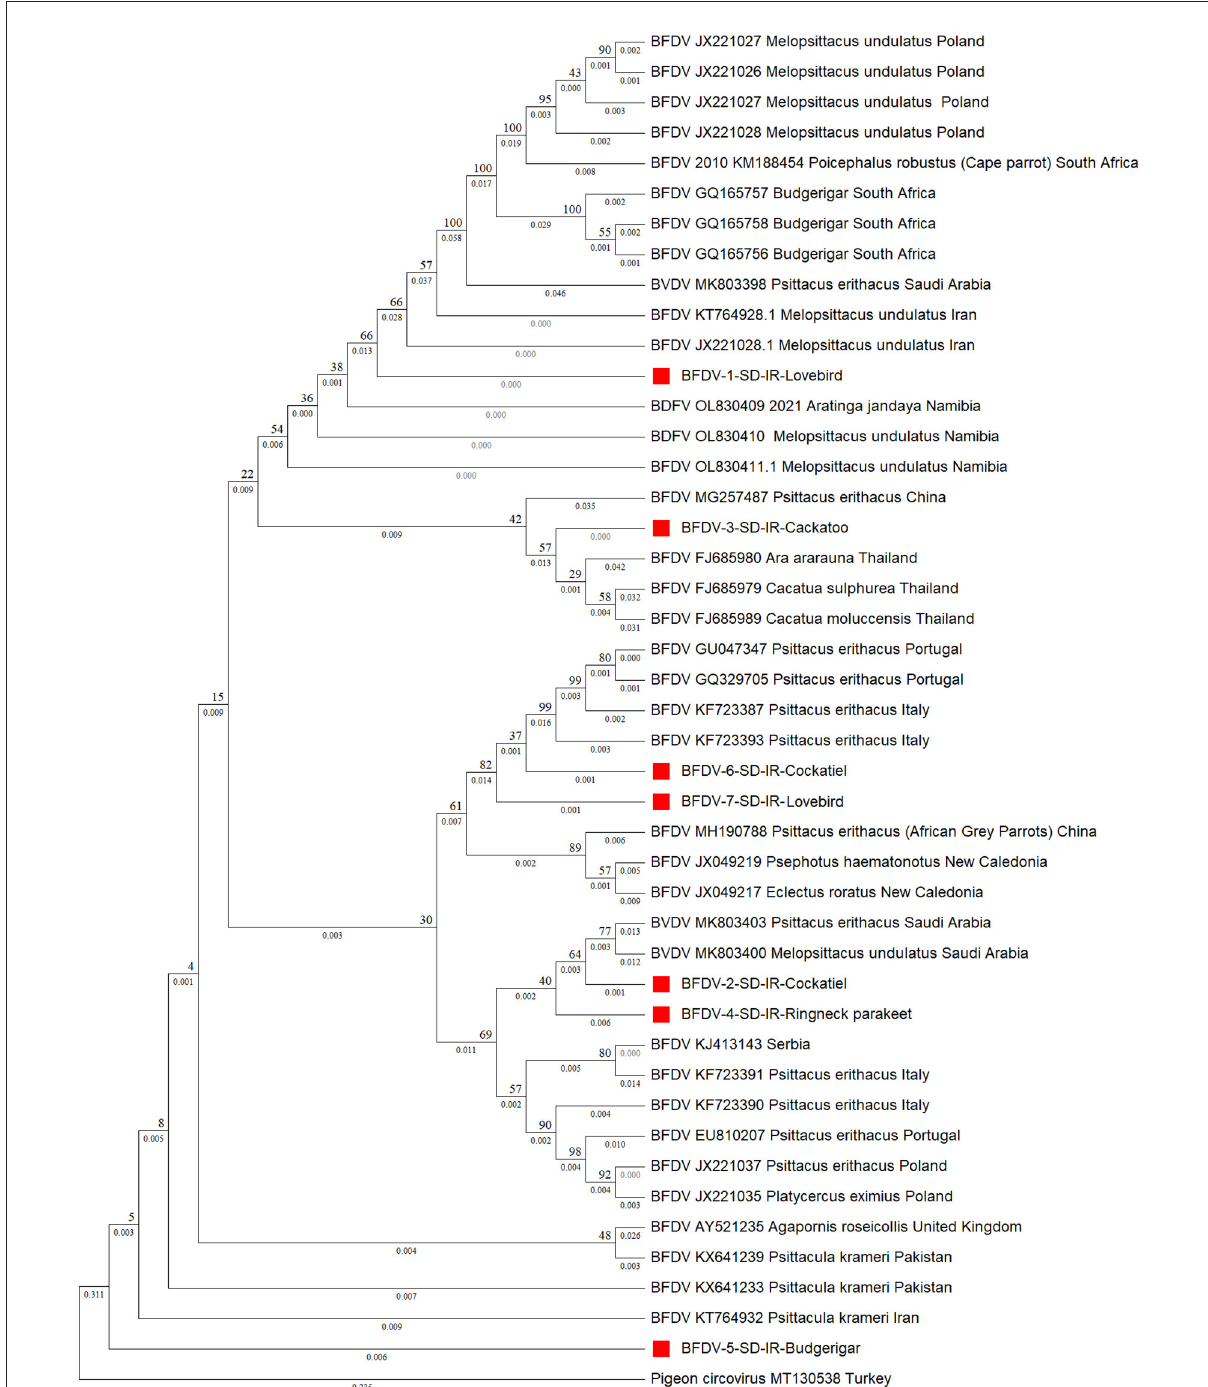
FIGURE3 Neighbor-joining phylogenetic tree constructed using Mega ver. 11 at 1,000 number of bootstrap replications on rep sequences, demonstrating distance of the infected hosts (OP039995-OP040000) in relationship to public BFDV rep sequences from other Psittaciformes available in GenBank. Numbers at nodes rep represent the frequency of Bayesian posterior probability between two subsequent clusters or strains. Each sequence labeled with BFDV year of specimen collection, GenBank accession numbers, host species, and country. The samples used in this study are marked with a red color cubic ( (cid:4) )